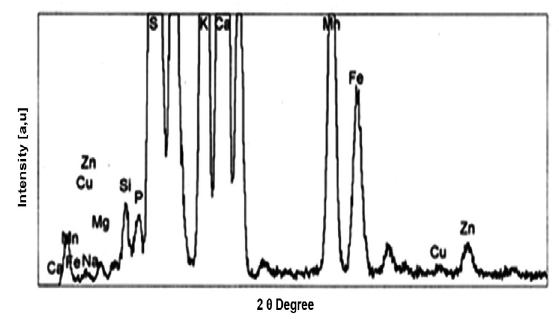
Fig. 3.The chemical composition of pine wood ash (wt %)